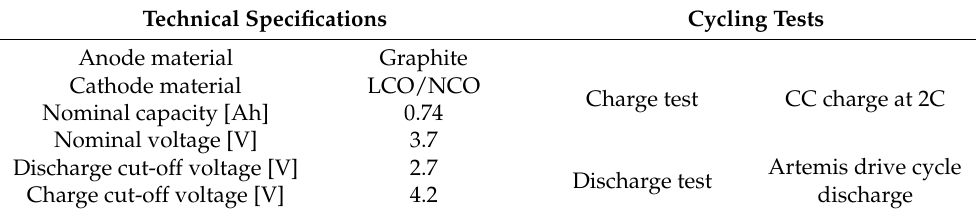
Table 2. Specific cycle condition of the Oxford